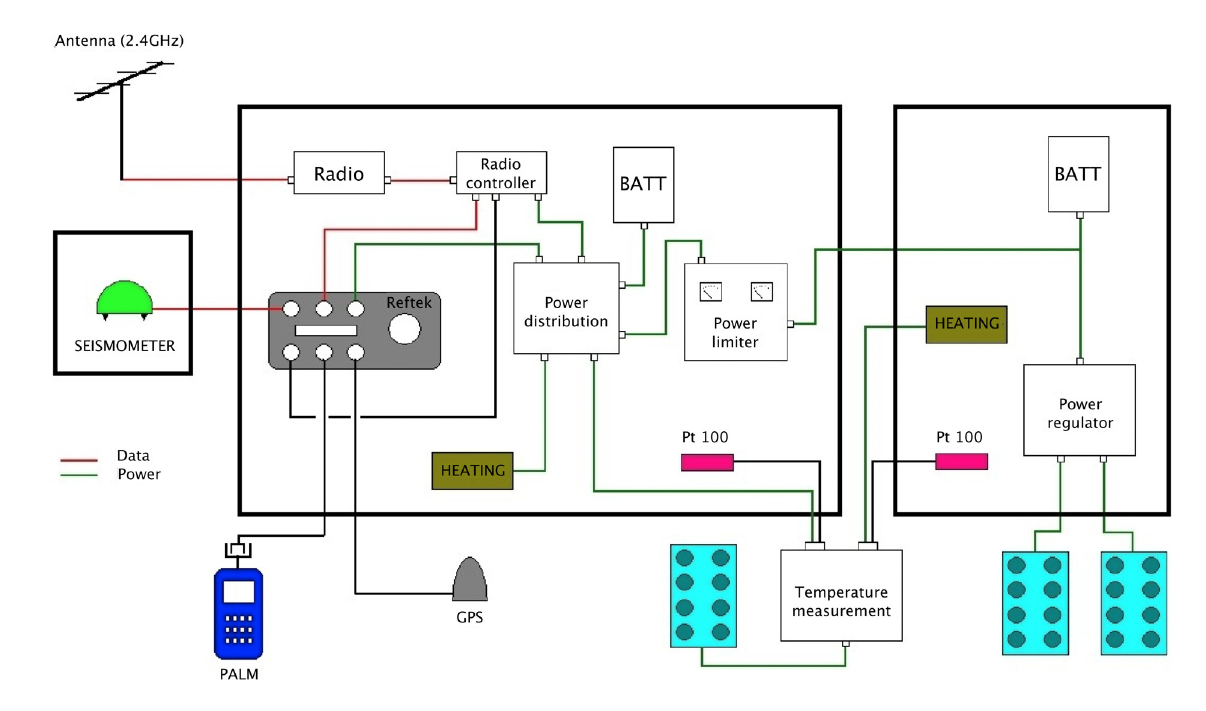
Figure 3. Design of the first prototypes of the CASE-IPY autonomous seismic stations (3-box design with radio transmission to Concordia base). Heating and radio transmission were removed, and the acquisition (Reftek box) and battery (BATT) boxes were merged for the final